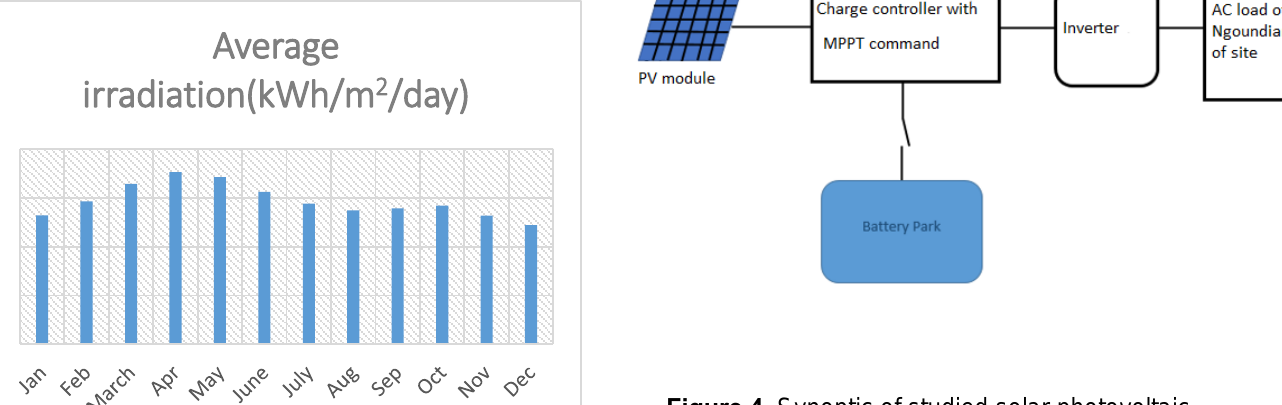
Figure 4. Synoptic of studied solar photovoltaic